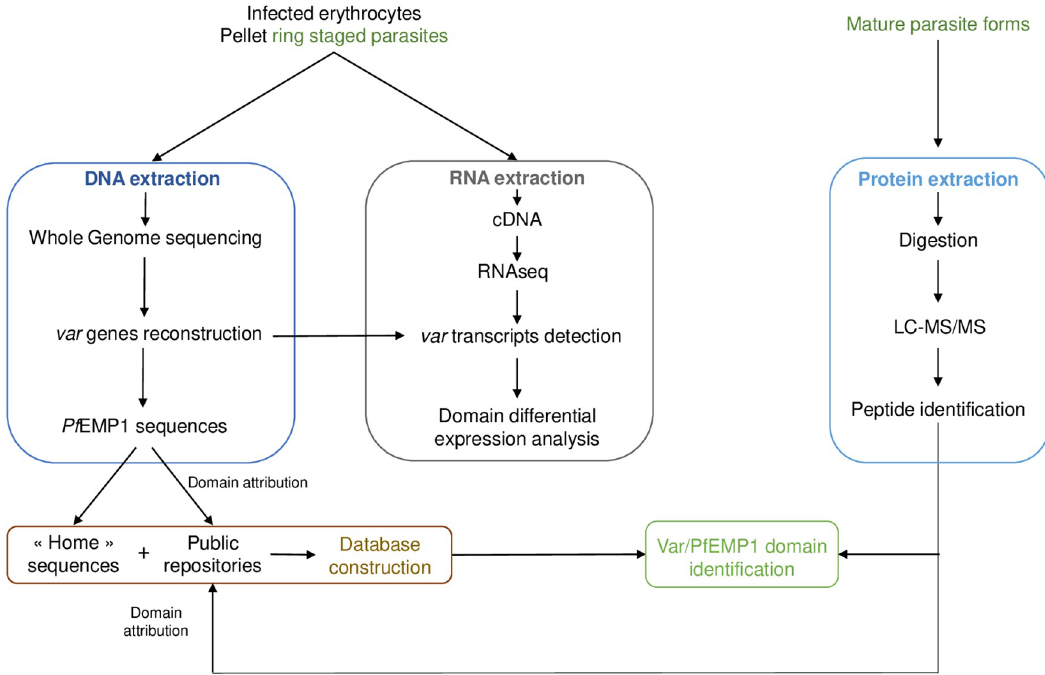
Fig 1. Experimental design—Proteogenomic approach on field samples for PfEMP1 identification. Whole blood sample from patients are collected. DNA and RNA are extracted from parasite’s ring forms. For LC-MS/MS analysis, parasites are matured, and the corresponding proteins are extracted and analysed using the mass spectrometer. Whole genome sequencing data provides the var repertoire from each isolate and allows the assessment of RNA expression in each sample. In addition, WGS data were used to enrich the protein database for protein identification with LC-MS/MS